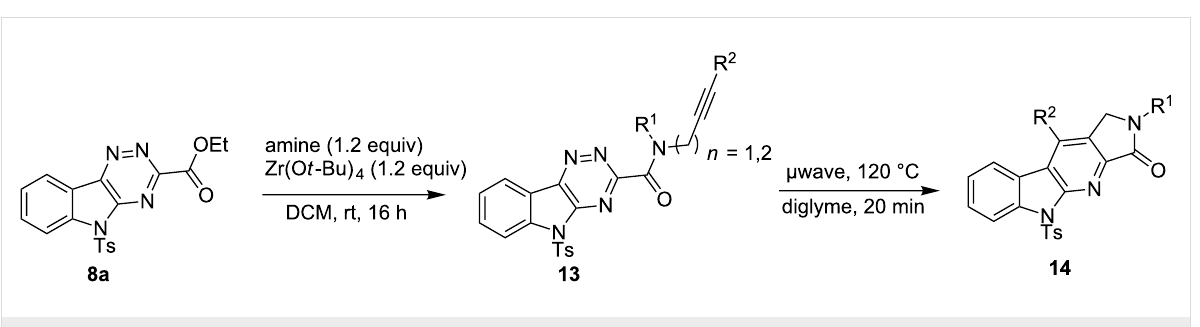
Scheme 6: Amidation/cycloaddition forming α -carbolines 14 .